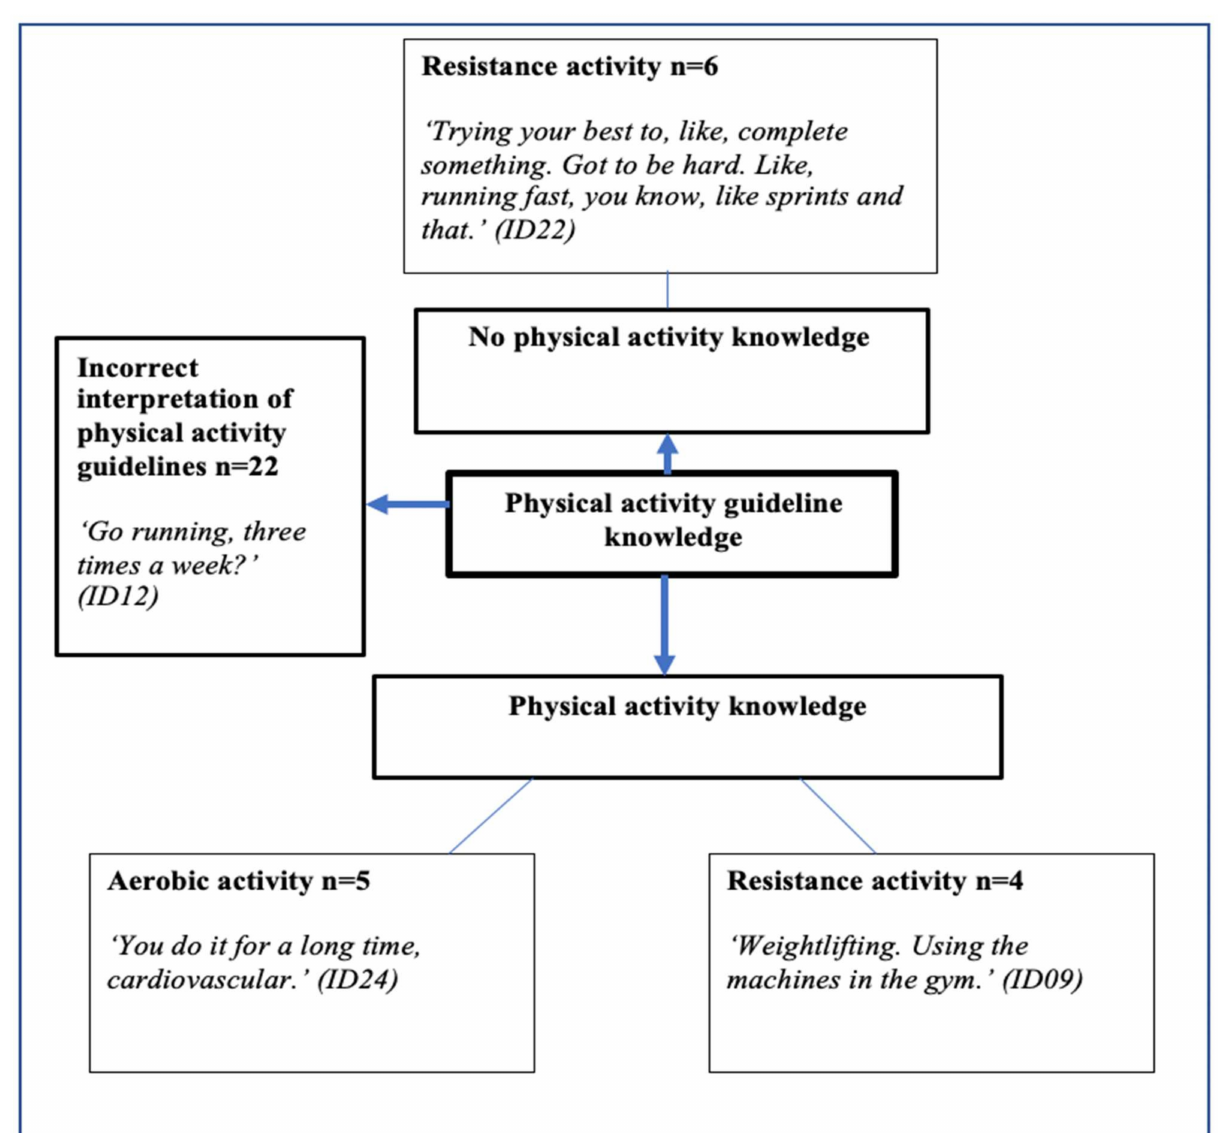
Figure 1. Physical activity guideline knowledge. +ve = positive; − ve =